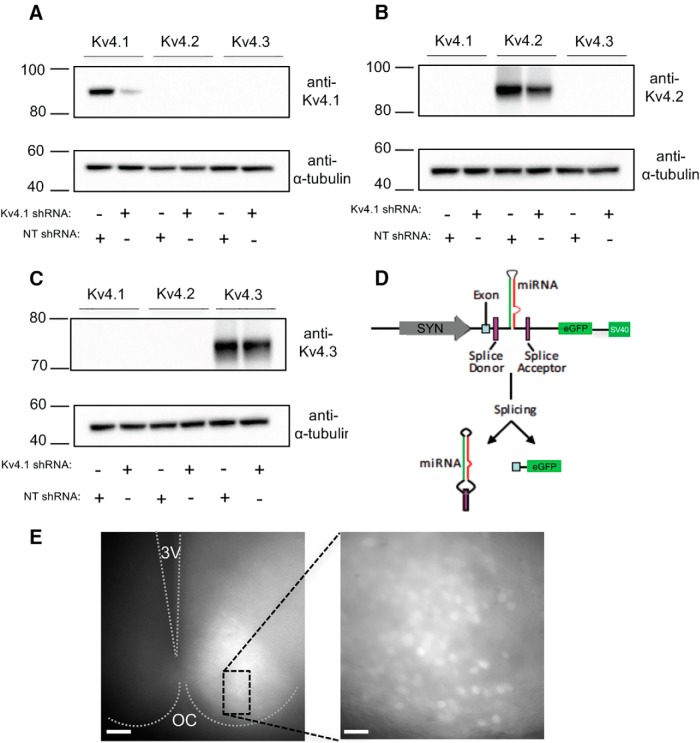

Validation of Kv4.1-targeted shRNAs. A–C, The Kv4.1-eYFP, Kv4.2-eYFP, or Kv4.3 construct was coexpressed with either the Nontargeted (NT) shRNA or the Kv4.1-targeted shRNA in tsA-201 cells. Approximately 48 h later, lysates were prepared, fractionated by SDS-PAGE, transferred to PVDF membranes, and probed with an anti-Kv4.1, anti-Kv4.2, or anti-Kv4.3 antibody. Blots were also reprobed with an anti-α tubulin (α-tubulin) antibody to verify equal loading of proteins. The Kv4.1-targeted shRNA markedly reduced the expression of Kv4.1, compared with the nontargeted shRNA (A), whereas neither Kv4.2 (B) nor Kv4.3 (C) expression was measurably affected. D, The Kv4.1-targeted and the nontargeted shRNAs were cloned, in a microRNA (miR30) context, between splice donor and acceptor sequences in an artificial intron downstream of the SYN promoter and upstream of the reporter (eGFP) cDNA (Norris et al., 2010). E, An acute SCN slice, prepared from an adult mouse 27 d following a unilateral injection of the Kv4.1-targeted shRNA-expressing AAV8 into the right hemisphere, is shown. In the left panel, a low-magnification fluorescence image reveals eGFP expression in the right hemisphere only. The third ventricle (3V) and the optic chiasm (OC) are marked. In the higher magnification image on the right, virally-transduced eGFP-expressing neurons are evident throughout the SCN. Scale bars: 200 and 50 μm in the left and right panels, respectively.